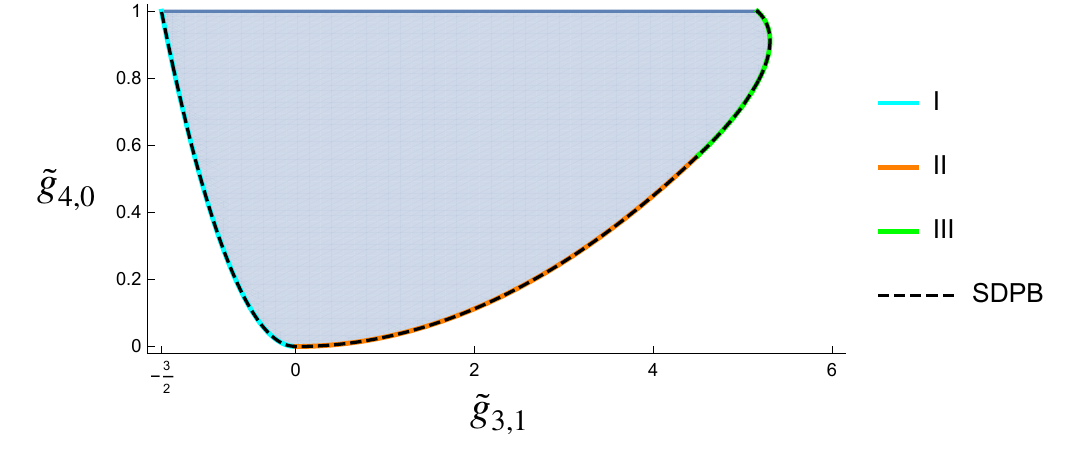
Figure 7 . ( ˜ g 3 , 1 , ˜ g 4 , 0 ) space with k = 4 null constraint, geometry vs